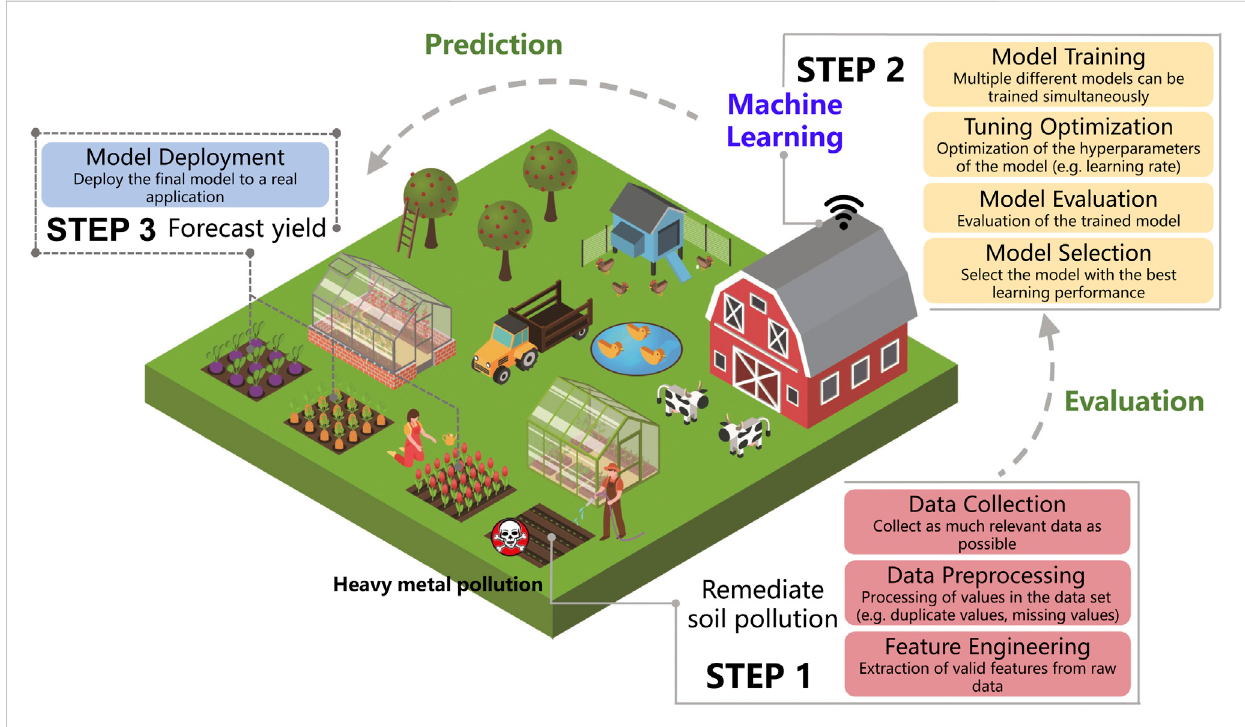
FIGURE 1 Application pattern diagram of machine learning model in heavy metal pollution remediation in